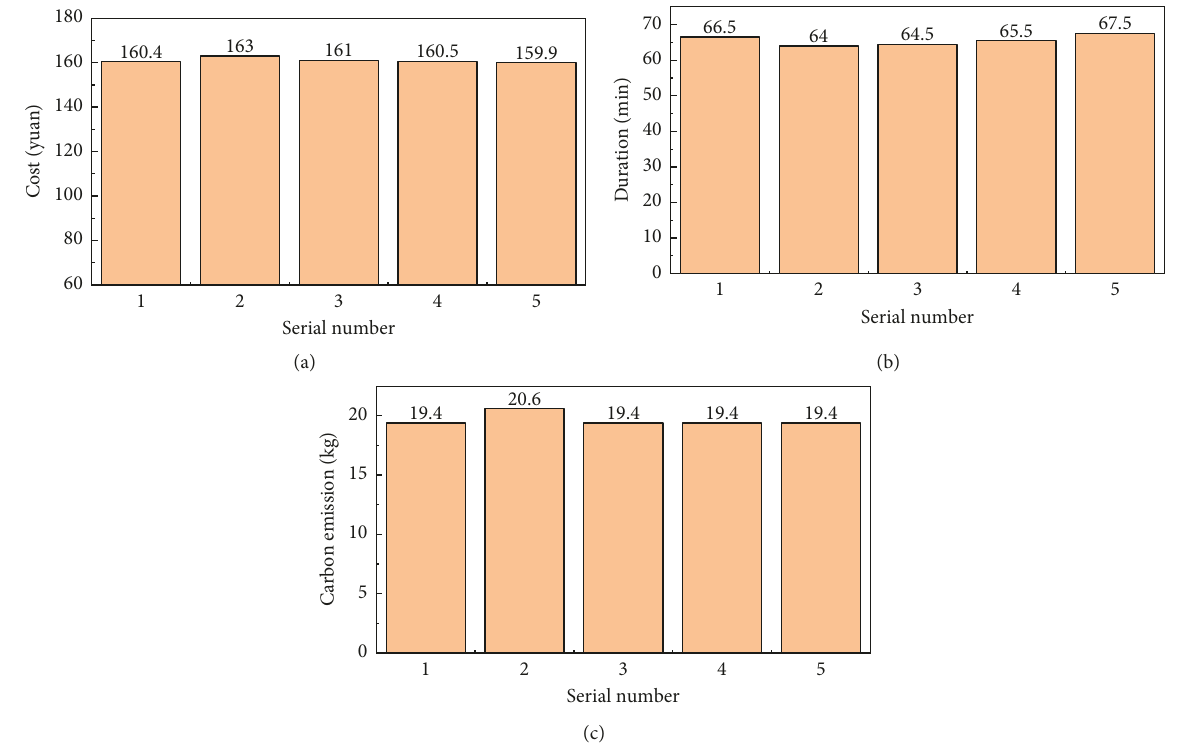
Figure 3: Optimal solution set of the original problem. (a) Cost. (b) Construction period. (c) Carbon